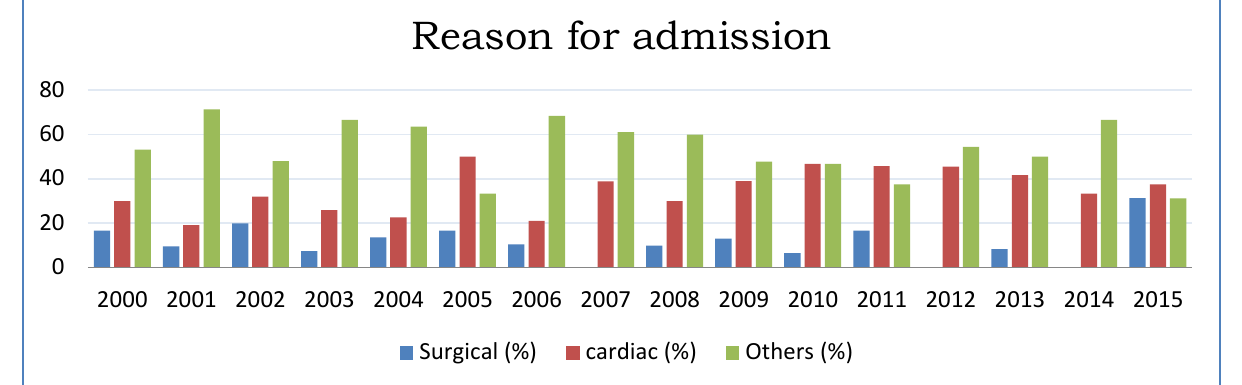
Figure 3- Trends in cause for admission.